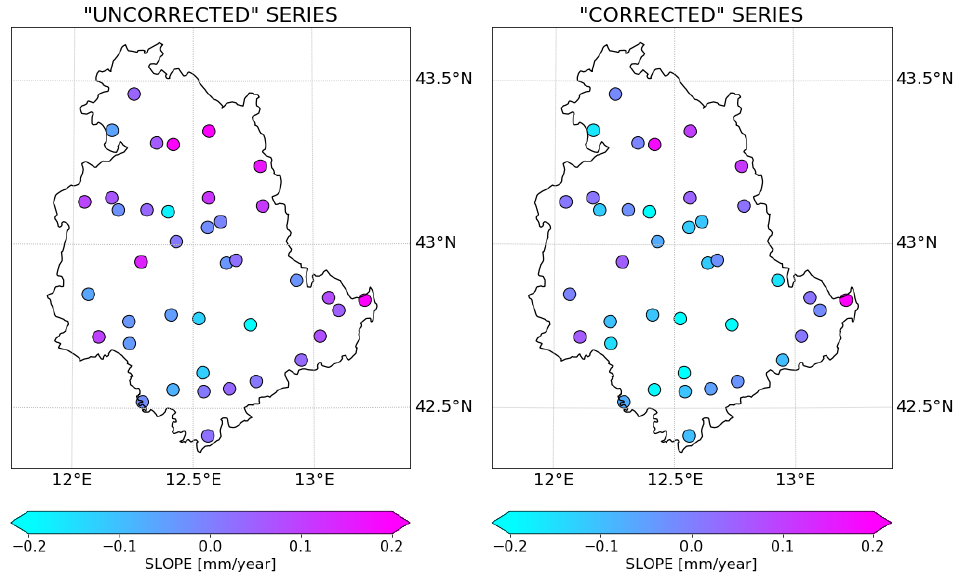
Figure 5. Values of the linear trend slopes for both “uncorrected” ( left ) and “corrected” ( right ) H d= 24 h series located in the corresponding geographic position of the rain gauge station.